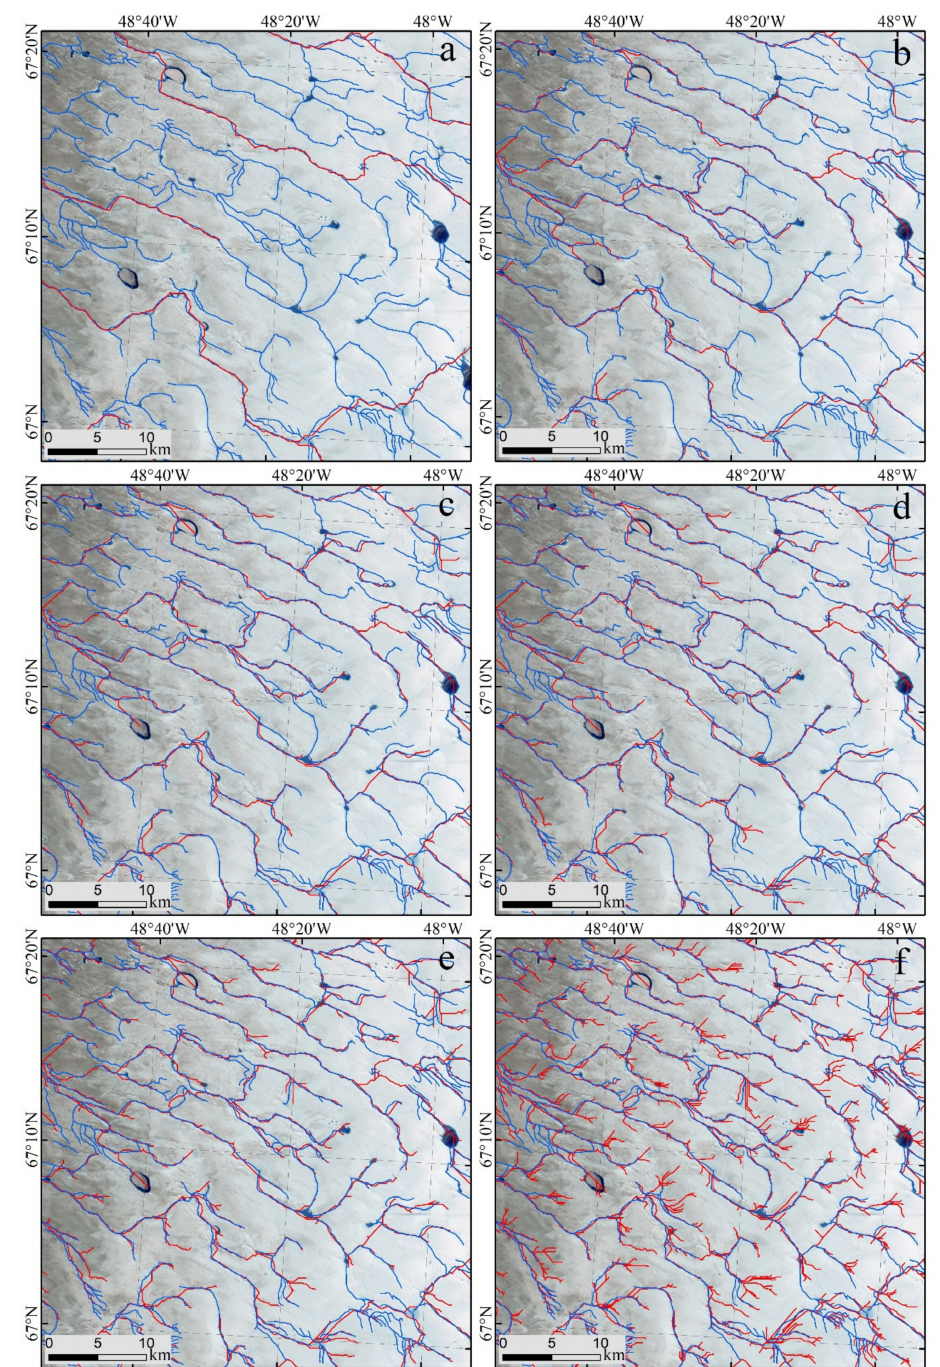
Figure 6. ( a ) River extraction results with a threshold of 25,000, ( b ) river extraction results with a threshold of 2000, ( c ) river extraction results with a threshold of 1000, ( d ) river extraction results with a threshold of 500, ( e ) river extraction results with a threshold of 300, ( f ) river extraction results with a threshold of 100. The background image is from Landsat-8, and the acquisition time of the image is August 6, 2014. The blue lines represent the river network digitized based on the Landsat image. The red lines indicate the river network extracted from